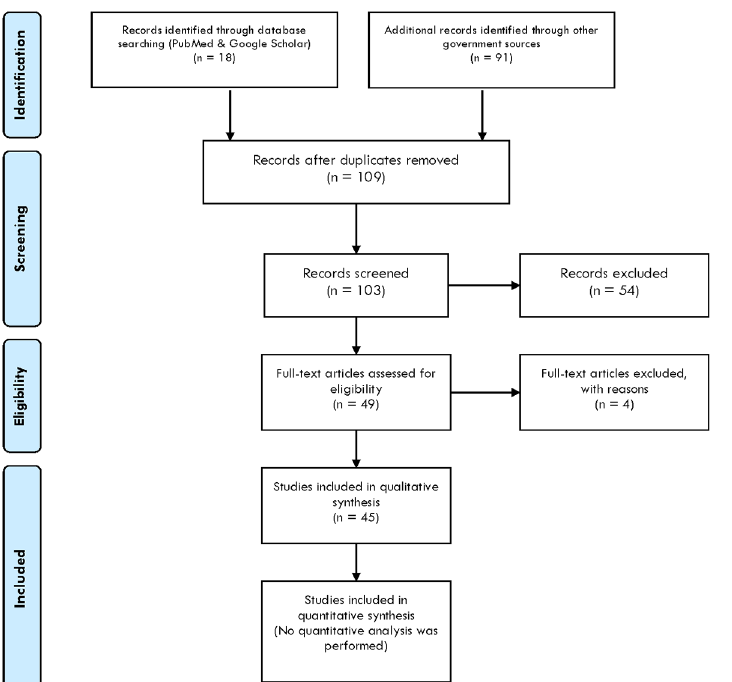
Fig 1. An overview of the search strategy depicted in PRISMA